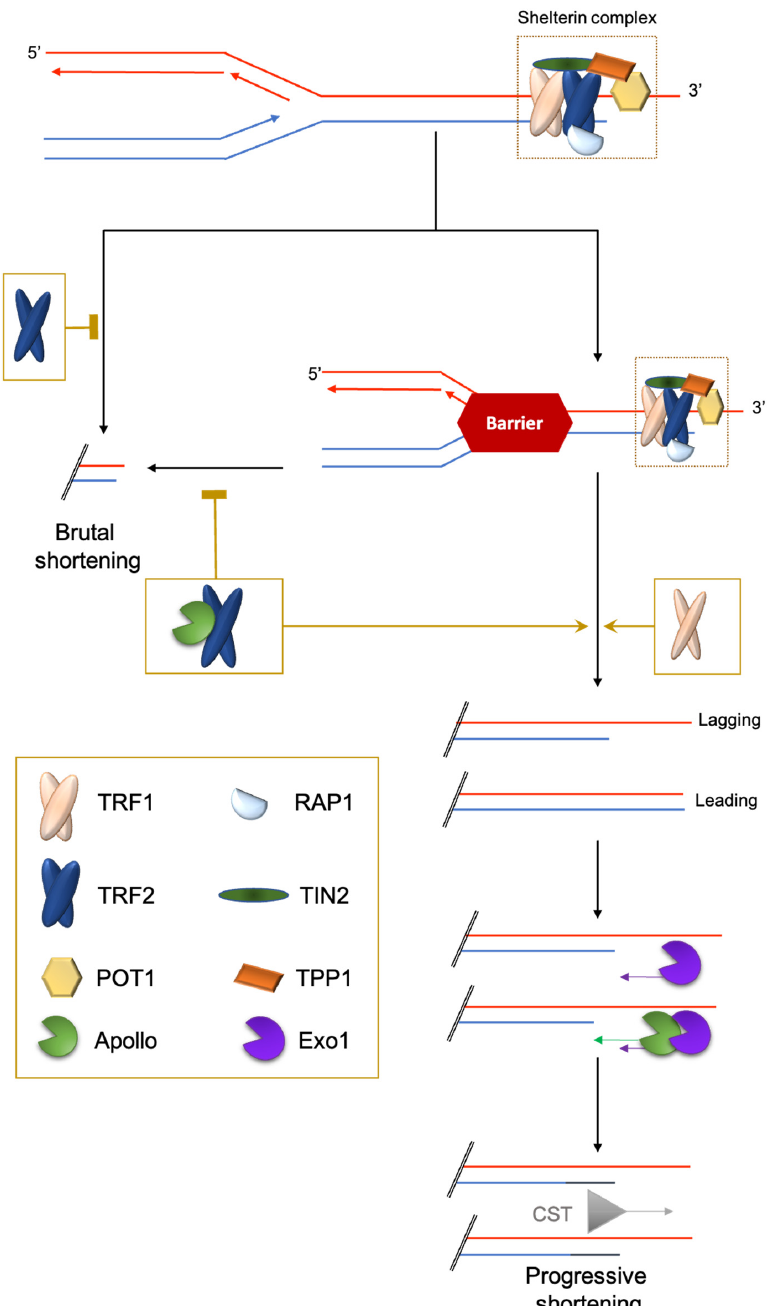
Figure 1. Brutal and progressive telomere DNA shortening. Telomere replication at the leading or lagging strands is not similarly regulated. At the G ′ -rich lagging strand, due to the end-replication problem, the parental strand is not completely replicated, triggering a 3 ′ -overhang. At the leading strand, there is a blunt end or 5 ′ protruding that is eroded in a manner coupled to replication by the TRF2-dependent recruitment of the 5 ′ -exonuclease Apollo. Next, at both strands, the Exo1 exonuclease prolongs the 3 ′ -overhang. Finally, POT1 recruits the CST complex (CTC1-STN1-TEN1) to replenish the 5 ′ -strands. The brutal appearance of critically short telomeres that cannot be explained by the progressive telomere shortening was first observed in yeast [11]. They are likely to stem from intra-telomeric recombination [12,13] or the collapse of DNA replication forks. Indeed, it is known that telomeric repeats can form recombinogenic t-loops [14,15] and are difficult to replicate